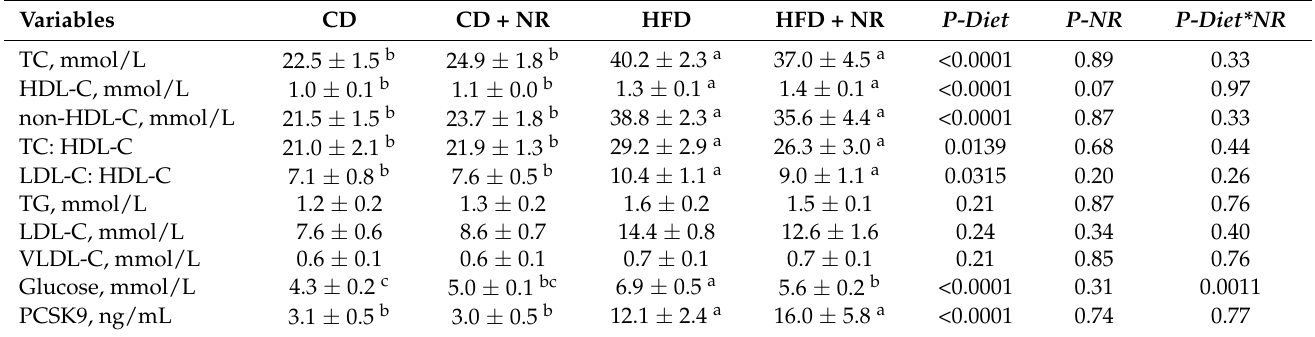
Table 1. Fasting blood concentrations of biochemical parameters in ApoE -/- mice fed with a CD or HFD, without or with NR at the end of the study 1